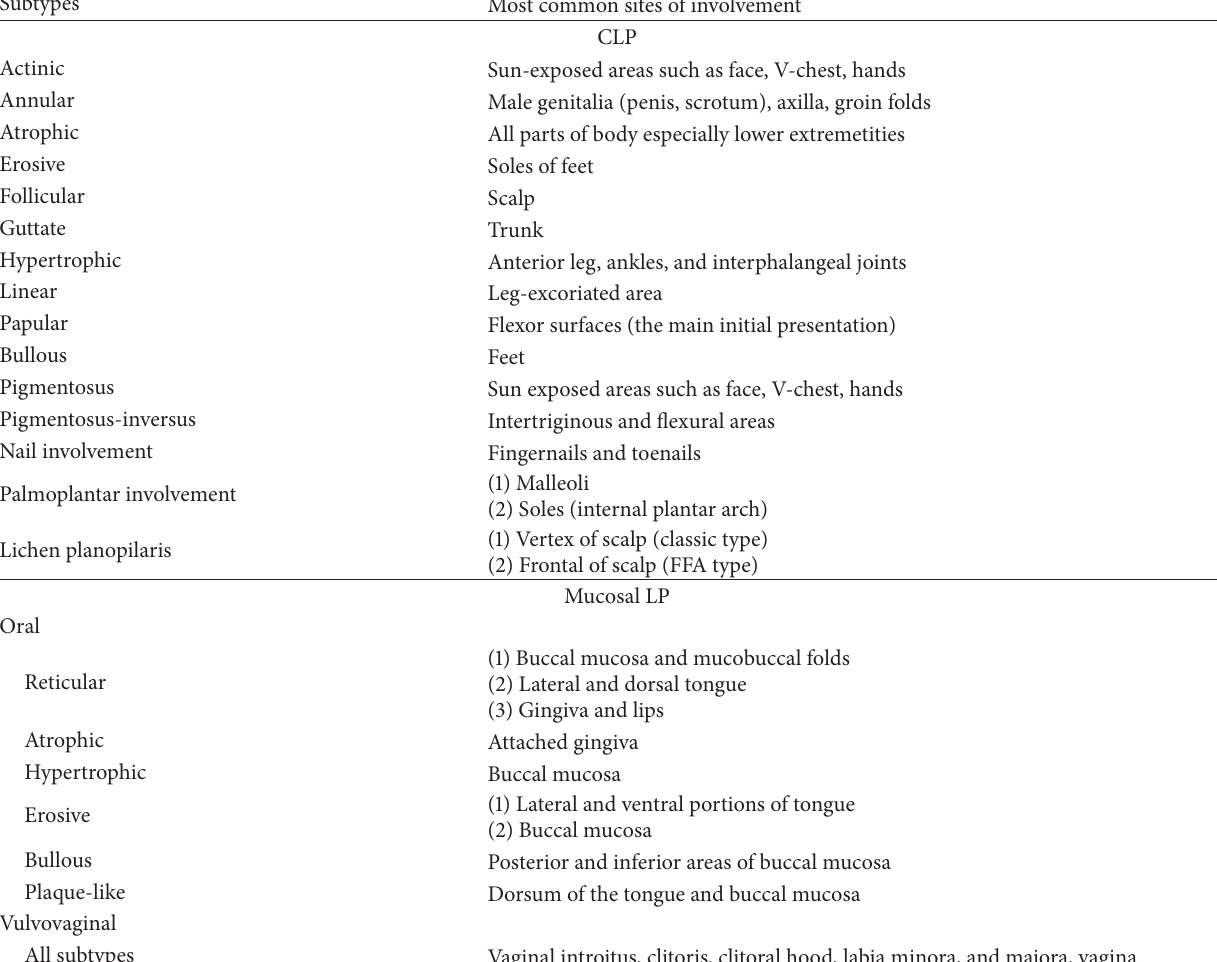
Table 1: The most common sites of involvement in LP based on subtypes.